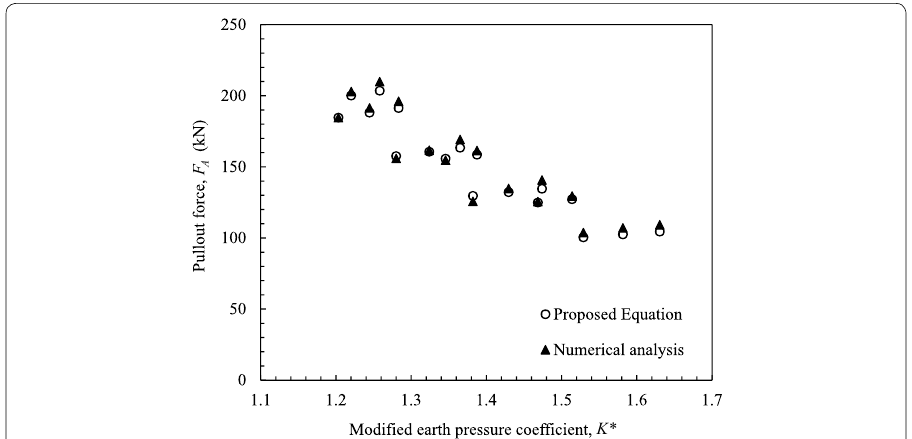
Fig. 11 Calculated pullout force using the proposed